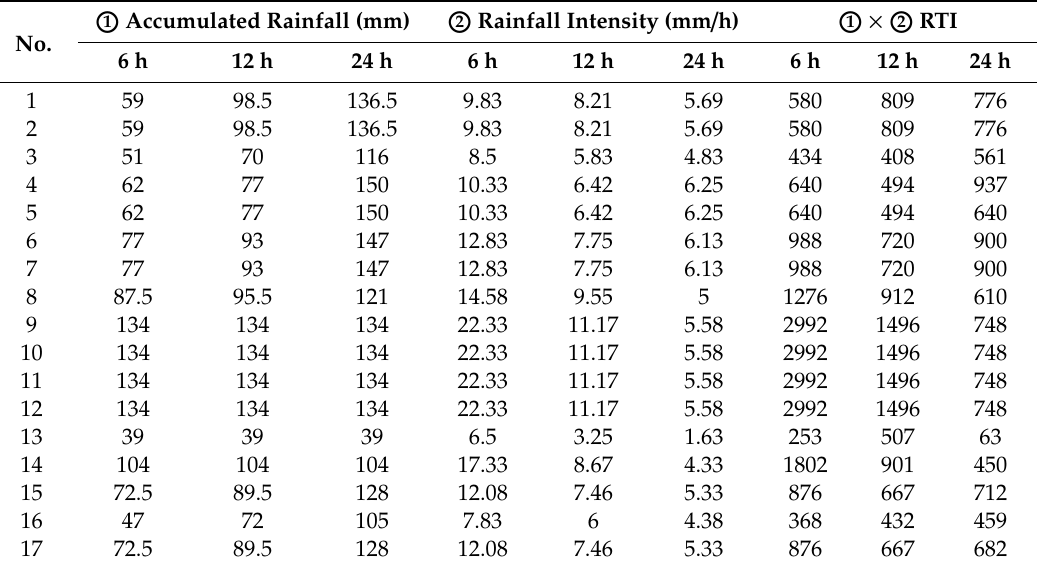
Table 4. Estimation of rainfall triggering index.